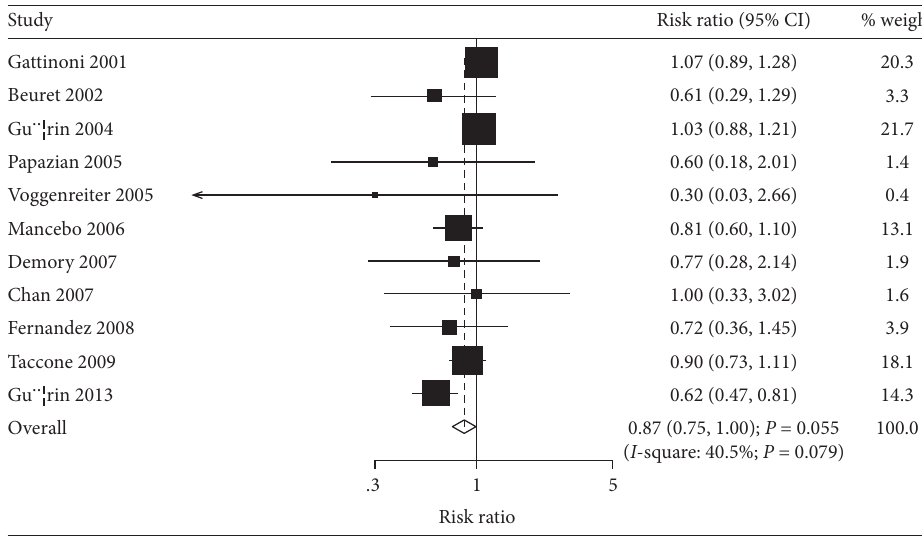
Figure 2: Prone versus supine position ventilation on the risk of